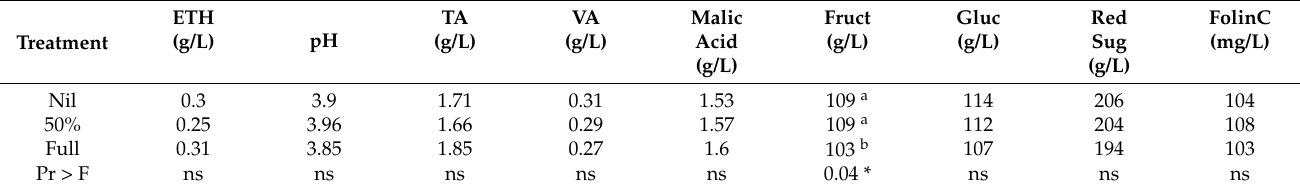
Table 3. Must analysis of fruit from three irrigation regimes for Xynisteri field trial, Kato Mylos, Cyprus, 2019 growing season.